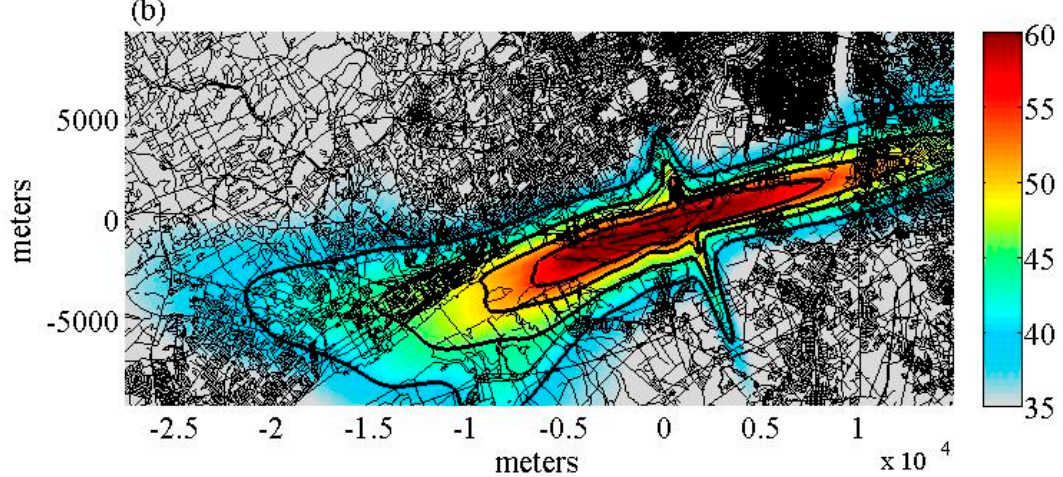
Figure 2. Average L night contours for ( a ) East flow configuration (13.2% of modeled nights) and ( b ) West flow configuration (86.3% of modeled nights). The contour lines shown are the 40, 45, 50, and 55 dBA L night contours.